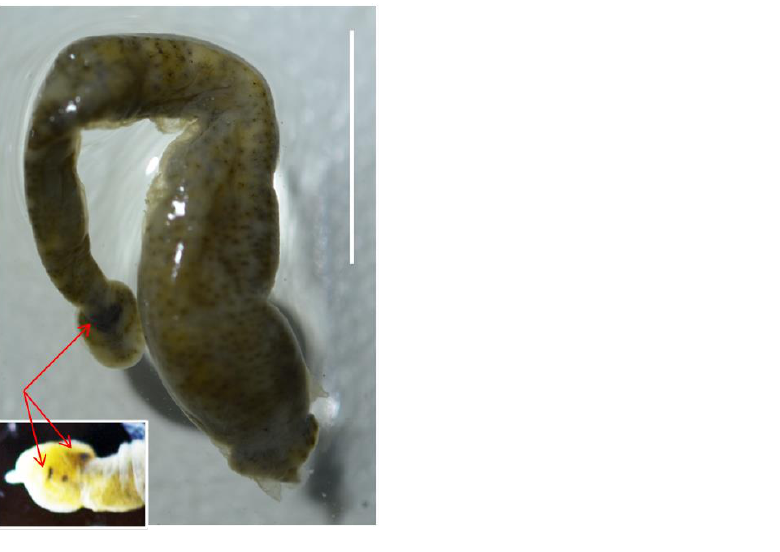
Figure 4. Morphology of the leech, an ectoparasite of the Selenga omul population. The largest specimen (15 mm in length). Scale = 5 mm. A close-up of the anterior sucker with well-preserved eyes is shown in the bottom left corner. The arrows indicate the eyes.